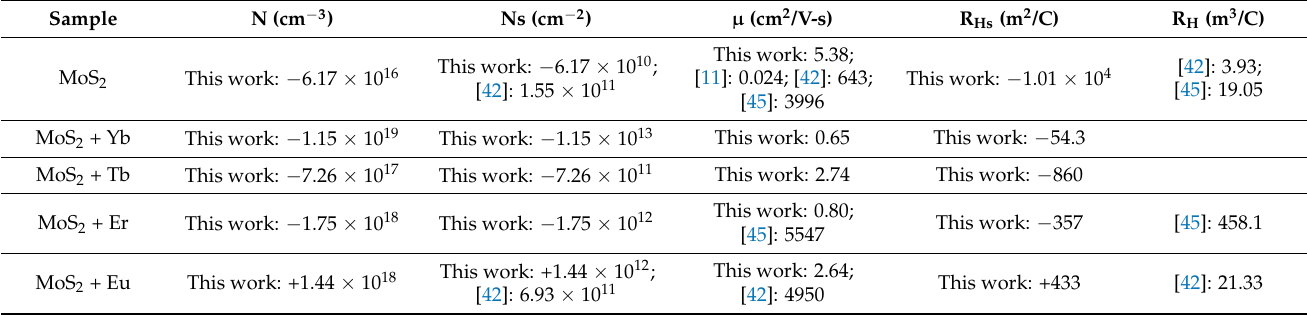
Table 1. The electrical parameters of the films after 550 ◦ C annealing in Ar + H 2